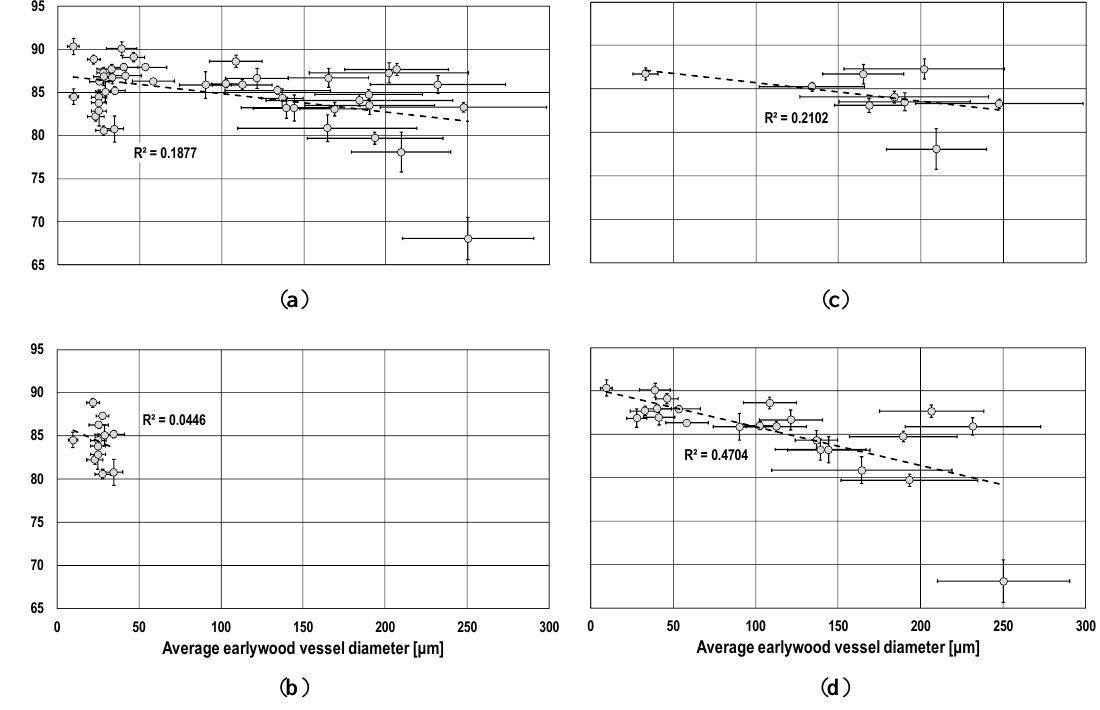
Figure 6. The relationship between the average earlywood vessel diameters and the resistance to impact milling (RIM): ( a ) all wood species (y = −0.0213x + 86.982); ( b ) softwoods (y = −0.0814x + 86.425); ( c ) ring- and semi-ring-porous hardwoods (y = −0.0213x + 87.857); and ( d ) diffuse-porous hardwoods (y = −0.0445x + 90.309).